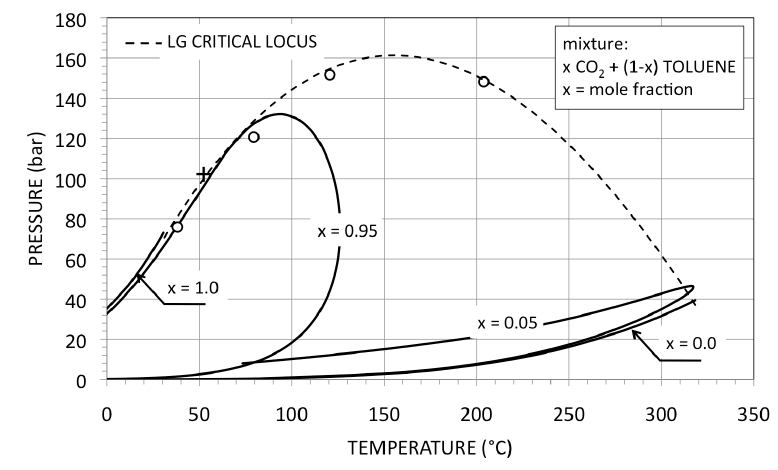
Figure 11. Liquid–gas (LG) critical locus and pressure–temperature curves for the carbon dioxide–toluene system. The binary interaction coefficients for the used equation of state are from the data bank of Aspen Plus. The open circles are from